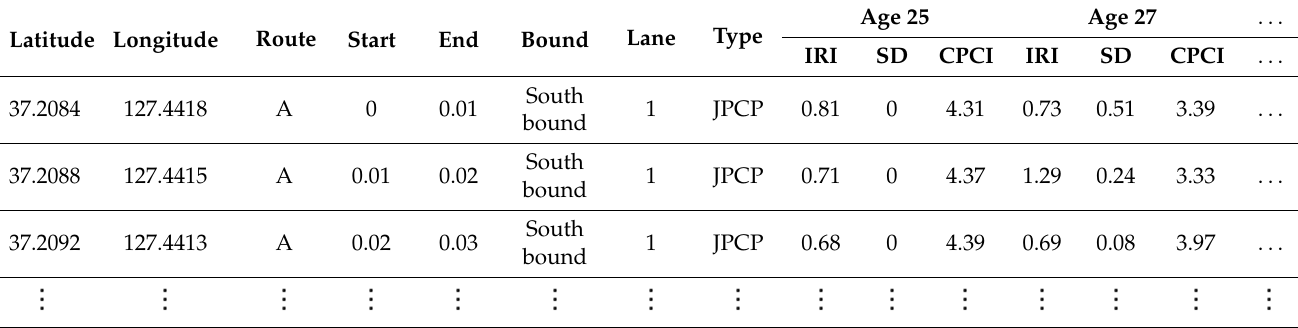
Table 1. Part of PMS DB in South Korea.